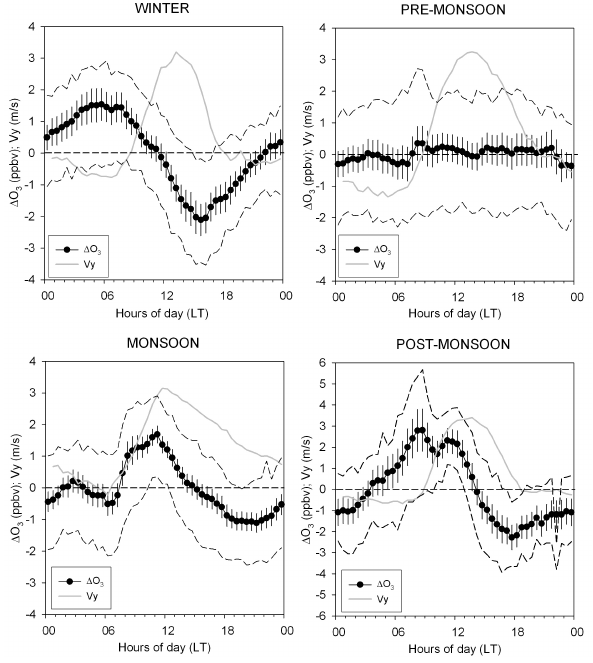
Fig. 4. Diurnal cycle of normalized O 3 values ( 1 O 3 ) and merid- ional wind component ( V y ) for the different seasons at the NCO-P. The vertical bars denote the 95% confidence level while the upper and lower dotted lines denote the 25th and 75th percentiles for 1 O 3